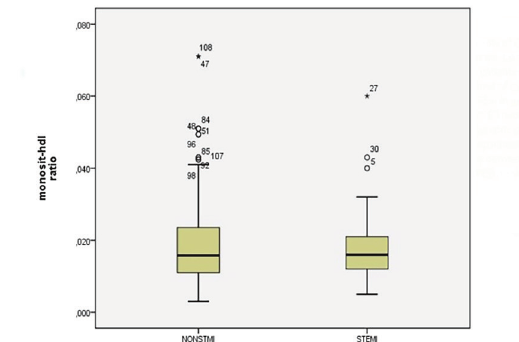
Figure 2 - Comparisons of MHR of the enrolled patients between the STEMI and NSTEMI groups